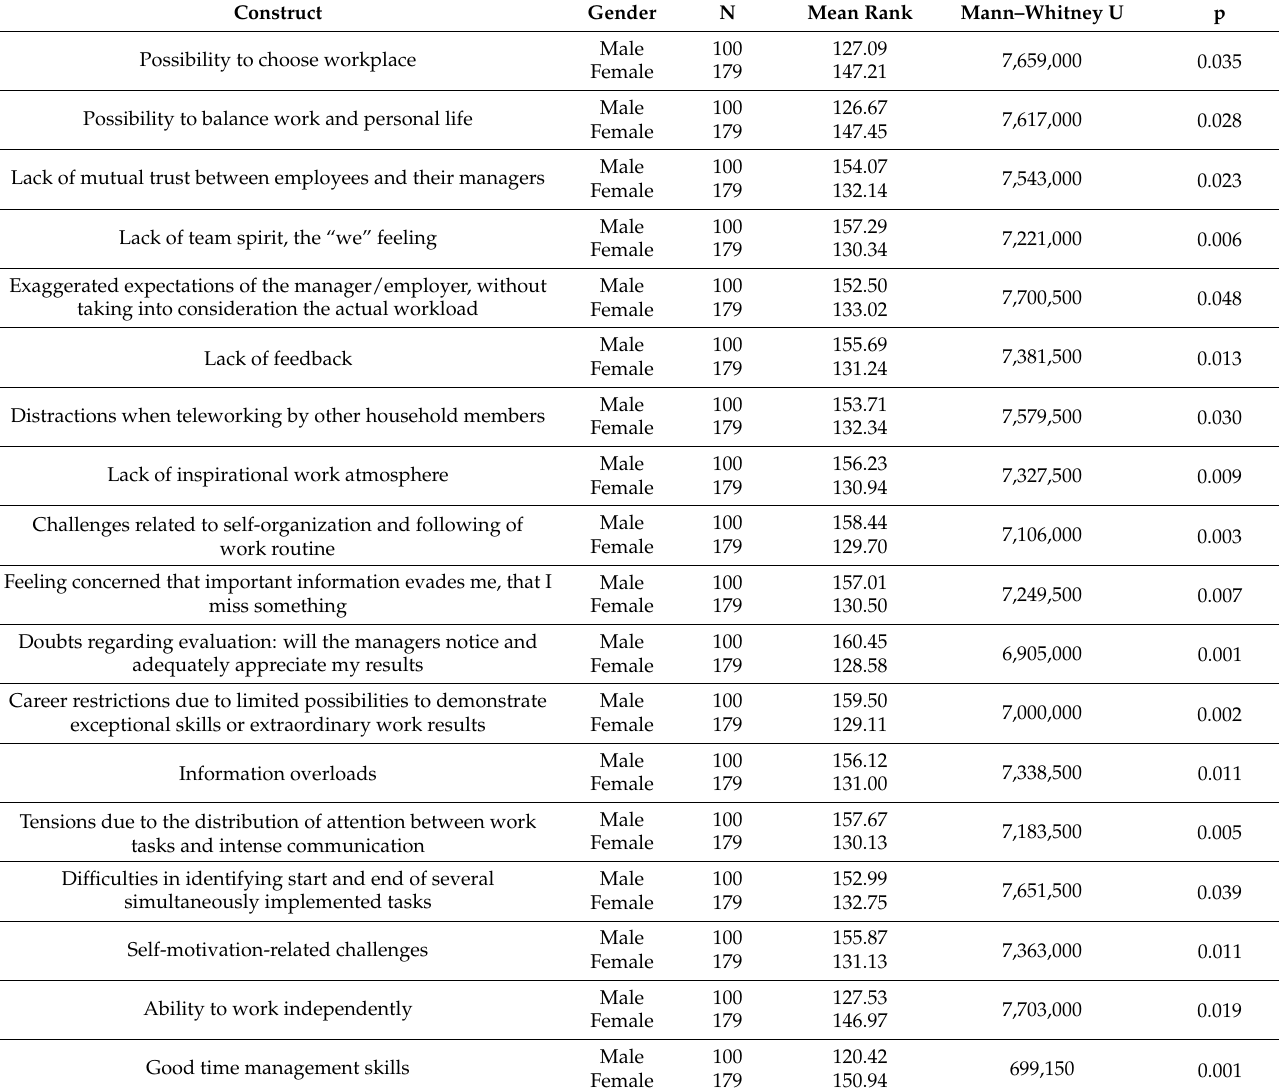
Table 8. The evaluation of teleworking between Millennial men and